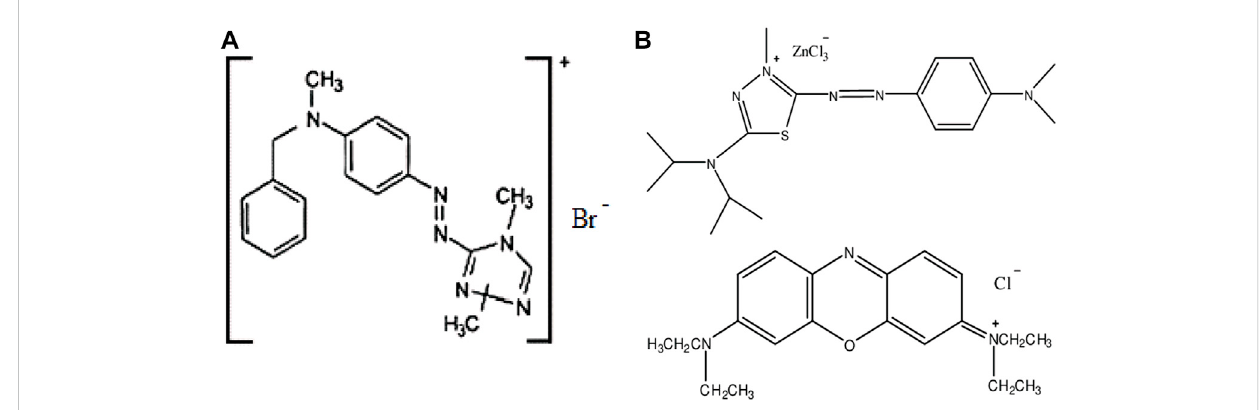
Figure 1 The chemical structures: Astrazon Red (A) and Astrazon Blue (B)